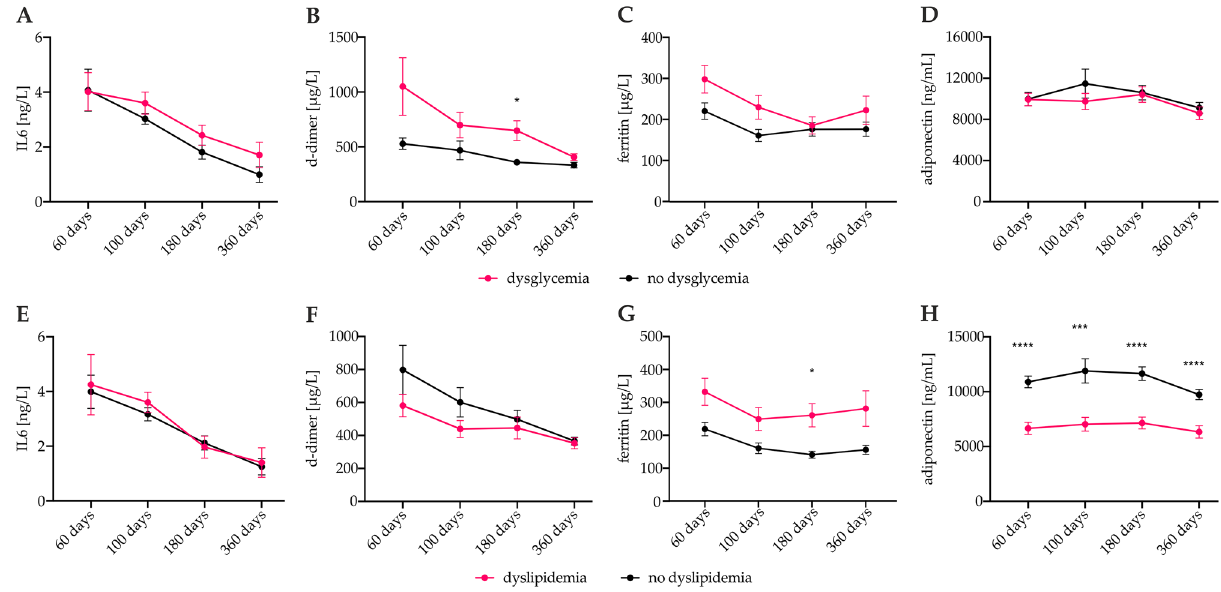
Figure 4. Serum markers of thrombo-inflammation in patients with dysglycemia and dyslipidemia at post-COVID-19 follow-up. COVID-19 patients were prospectively followed after acute COVID-19 and concentration of IL-6 ( A , E ), d-dimer ( B , F ), ferritin ( C , G ), and adiponectin ( D , H ) were prospectively assessed at 60, 100, 180, and 360 days after the onset of COVID-19. Subgroups are presented according to the presence of dysglycemia (A-D) or dyslipidemia (E–H), and statistical differences between these subgroups at each time point are indicated according to Mann Whitney-U tests * P < 0.05 and *** P < 0.001. Points depict means, error bars indicate standard error (SE). N 60days = 145, N 100days = 138, N 180days = 119, N 360days =